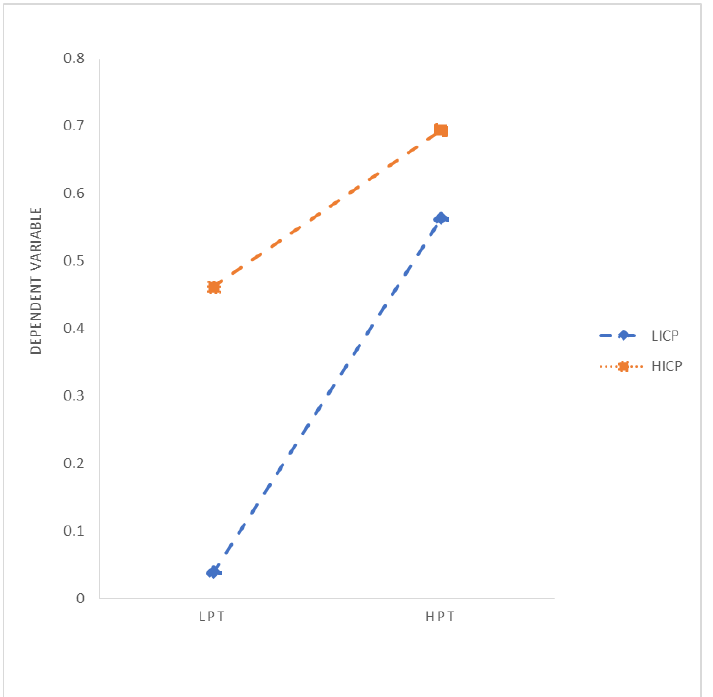
Figure 1. Moderating Effects of Internal Control Personality (Parental Trust). Notes: LPT: Low Parental Trust, HPT: High Parental Trust; LPC: Low Parental Communication, HPC: High Parental Communication; LPA: Low Parental Alienation, HPA: High Parental Alienation; LICP: Low Internal Control Personality, HICP: High Internal Control Personality.